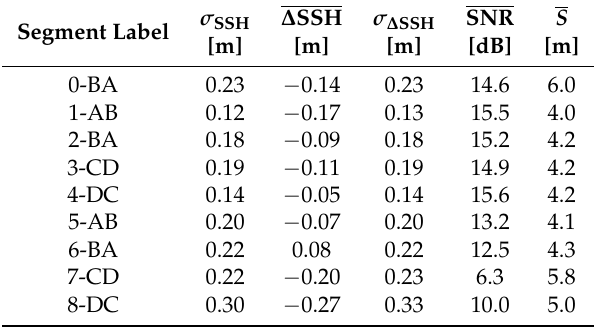
Figure 8. Time-series of SSH data (dots) for each PRN and frequency band (a darker tone is employed for L5). A solid line of the same color indicates the linear fit applied for each track. The corresponding values of SSH ref (black) and Finnish N2000 height system (gold) are also plotted. Table 3. Altimetric results for GPS PRN01 with an integration time of 10 m (coherent) and 10 s